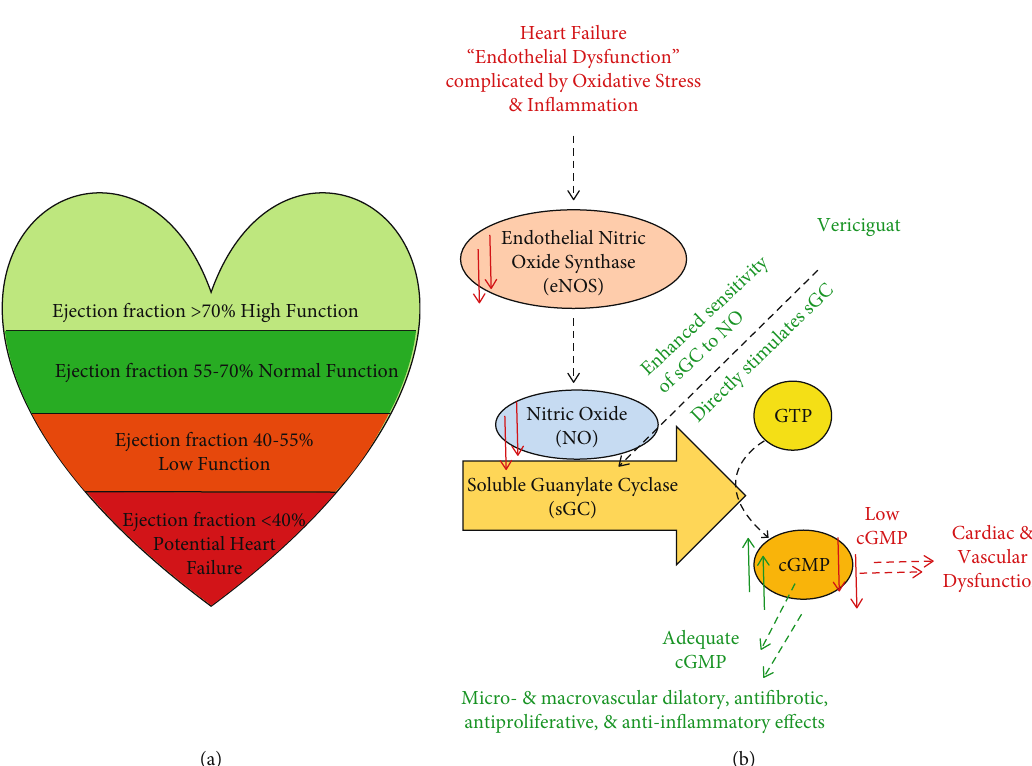
Figure 1: (a) The correlation between the ejection fraction and the cardiac function. (b) Mechanisms of action of vericiguat. Red arrows: heart failure is characterized by endothelial dysfunction, oxidative stress, and in fl ammation which leads to reduced nitric oxide (NO) bioavailability and inadequate activation of intracellular soluble guanylate cyclase (sGC). The resulting cyclic guanosine monophosphate (cGMP) de fi ciency is linked to cardiac and vascular dysfunction. Green arrows: vericiguat directly and indirectly increases the available amount of cGMP leading to various bene fi cial e ff